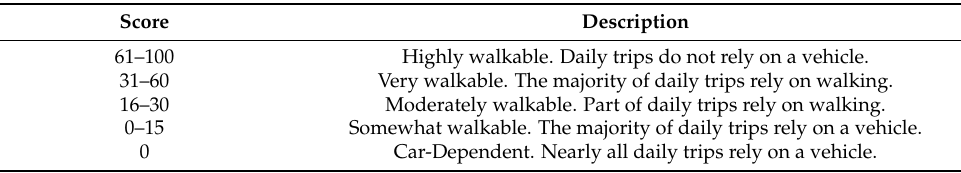
Table 2. Grade of the 15-min walkable neighborhoods